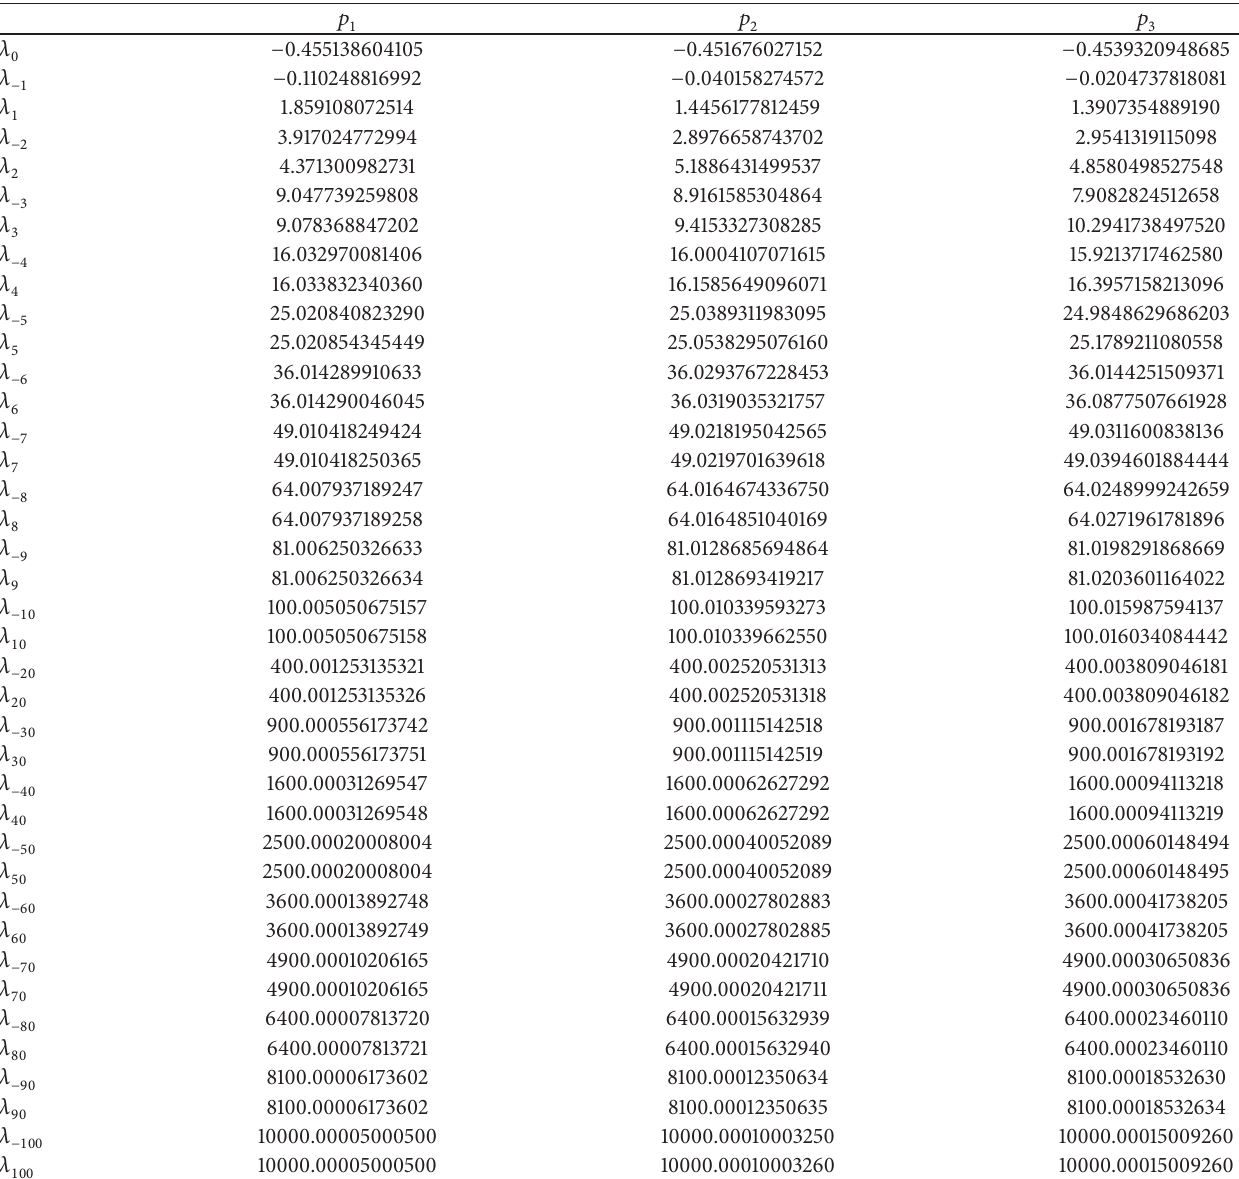
Table 4: Approximation of